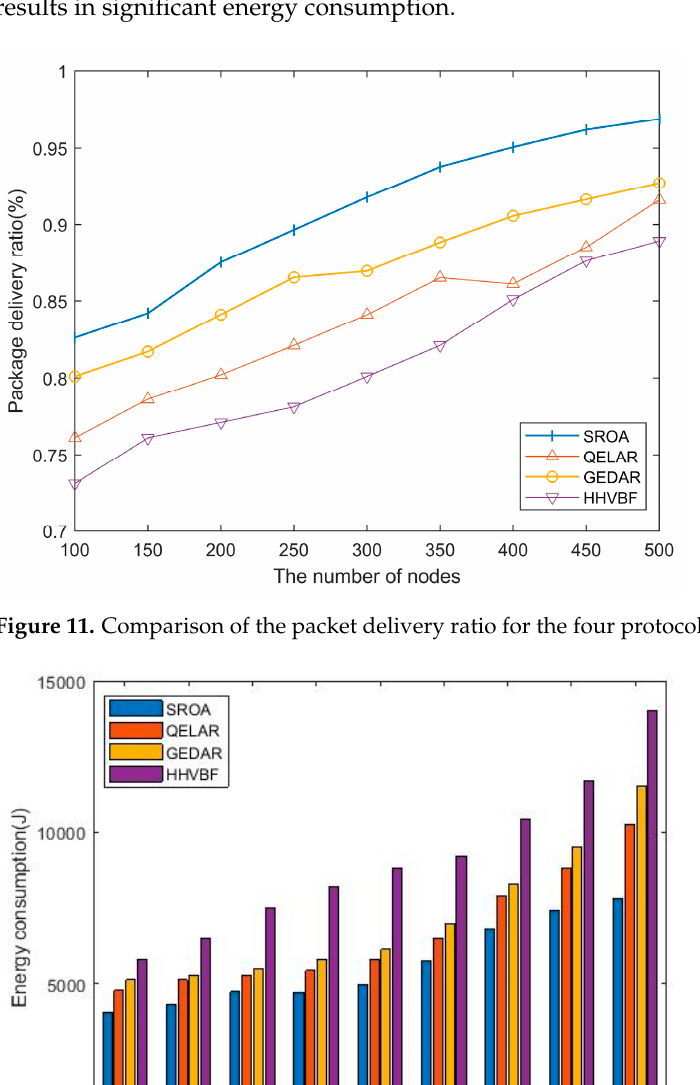
Figure 11. Comparison of the packet delivery ratio for the four protocols.